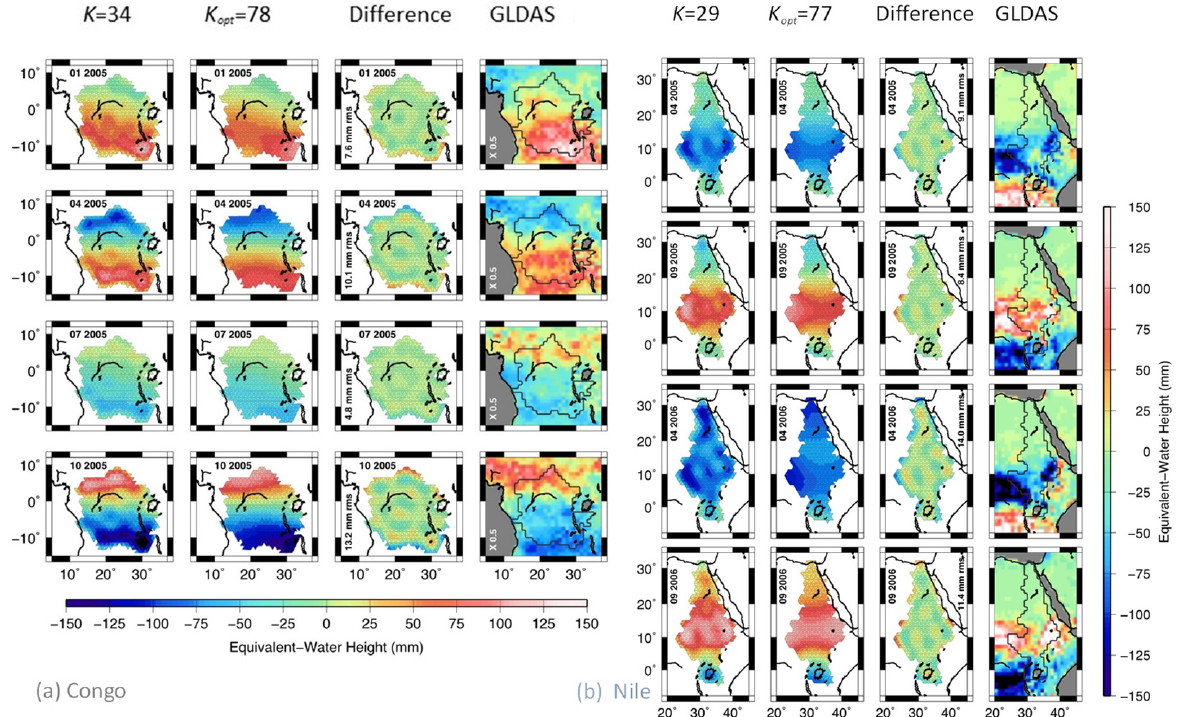
Figure 3. Impact of the optimized truncation K opt compared to the conventionally used Shannon truncation ( a ) for the Congo hydrographic basin. The difference between both methods highlights the loss of the small-scale coefficient for the Shannon truncation K. For validation purposes, we show the GLDAS solution for the considered period: January–October 2005. To obtain the equivalent water height in mm, we divide the GLDAS solution by a factor of 2, as many authors have done; ( b ) for the Nile watershed, the difference between both methods highlights the loss of small-scale coefficient for the Shannon truncation for validation purpose. We show the GLDAS solution for the considered period: April 2005 to September 2006. To obtain the equivalent water height in mm, we divide the GLDAS solutions by a factor of 2, as many authors have done.